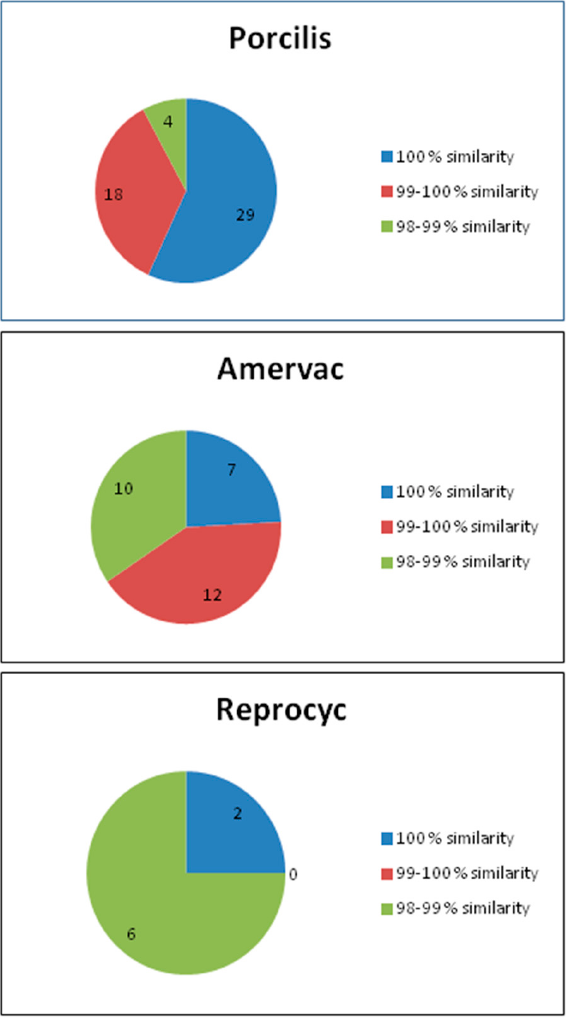
Figure 3. Distribution and sequence similarity of vaccine-related ORF7 sequences.